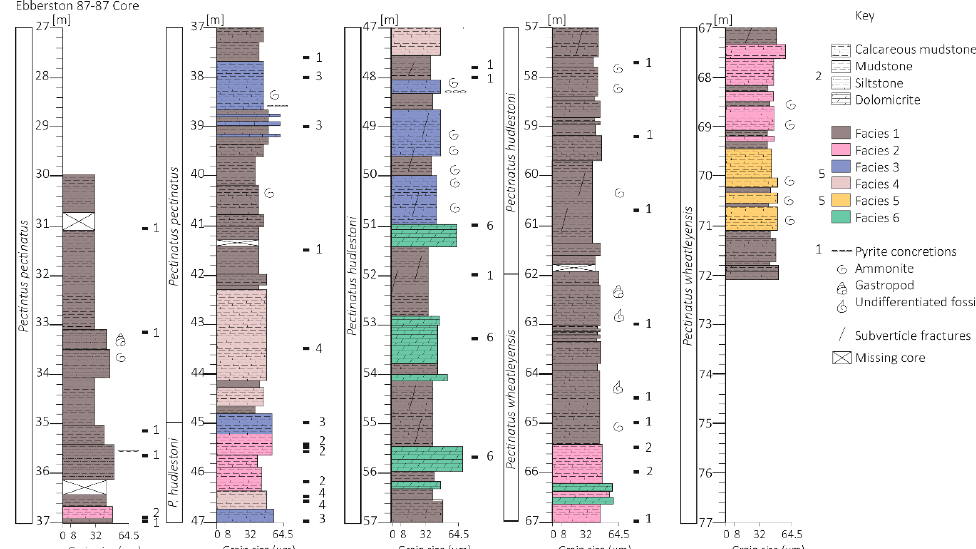
Figure 2. Lithographic log of the EB87 Core, redrawn from the IFPEN archives. Vertical unit is meters below surface. The black horizontal lines mark the location of thin sections and the numbers next to them indicate the facies defined in the present study. Facies 1 = Clastic-detritus-rich medium mudstone, Facies 2 = Organic material and calcareous pellet-rich, laminated mudstone, Facies 3 = Coccolith-dominated medium mudstone, Facies 4 = Agglutinated foraminifera bearing, medium to coarse, carbonaceous mudstone, Facies 5 = Biogenic detritus dominated, fine to medium mudstone, and Facies 6 = Carbonate-cemented, fine to medium mudstone. The IFPEN lithographic log and the petrographic data have been combined to extrapolate the facies model over the whole core; this interpretation is colour coded on the log.